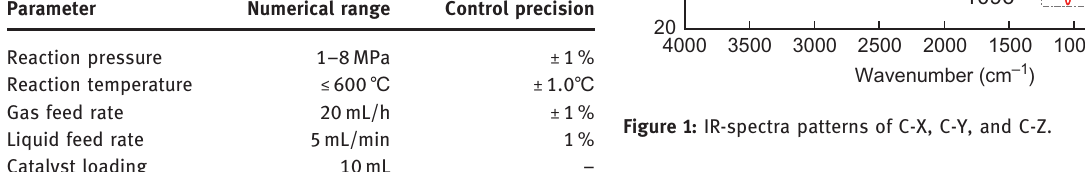
Table 2: Design technical parameters (conditions: reaction pressure, reaction temperature, gas feed rate, liquid feed rate, and catalyst loading).